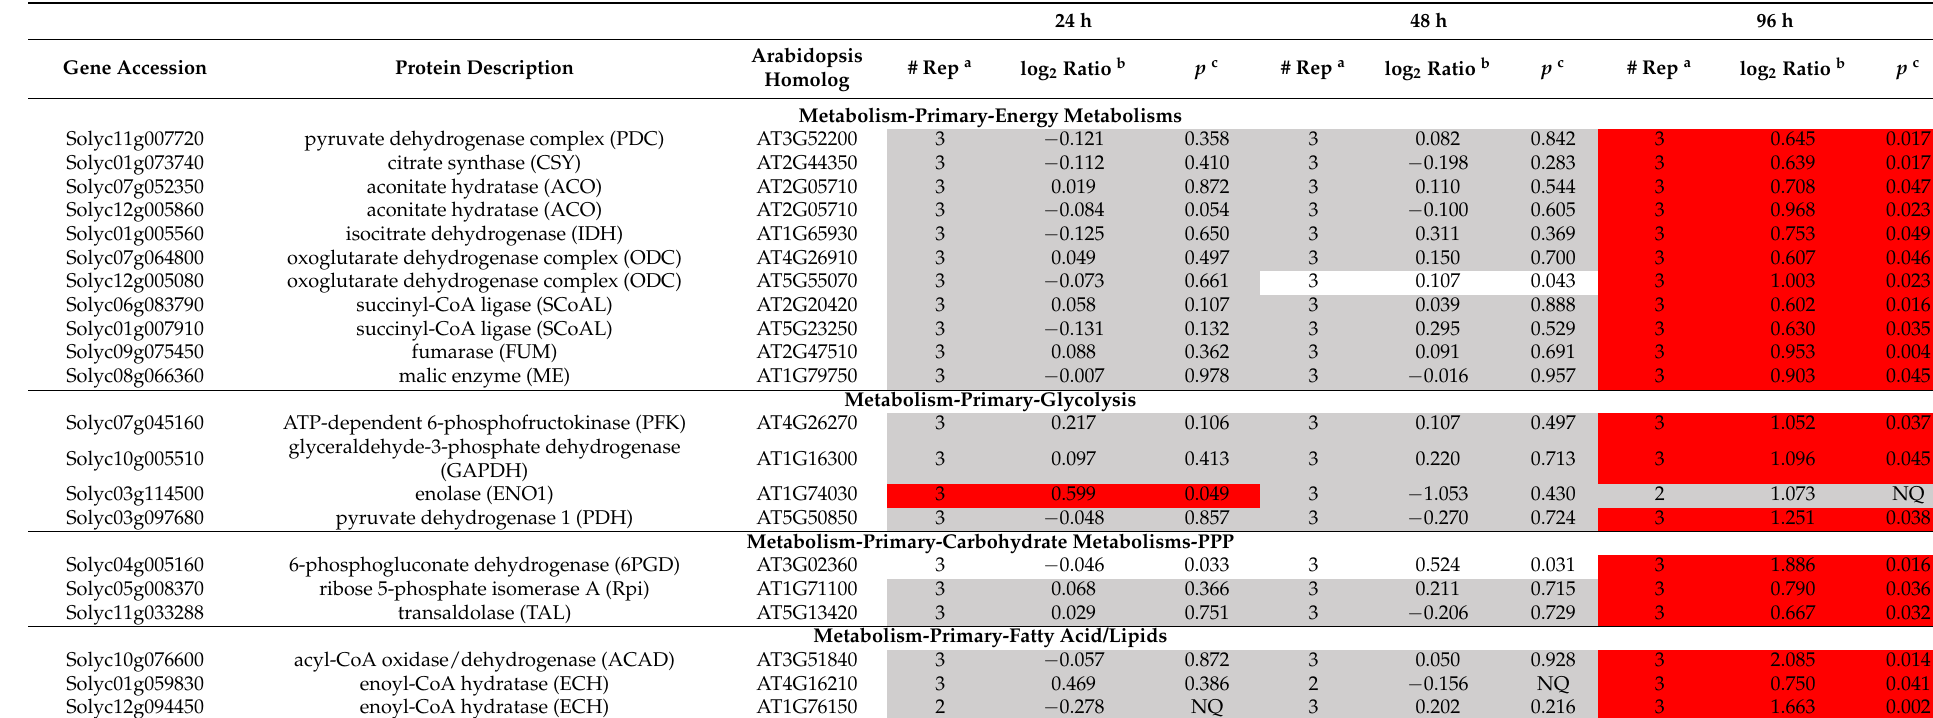
Table 5. Proteins involved in energy metabolisms with a significant change in abundance at 24, 48 and 96 h post-inoculation with P. infestans . 24 h 48